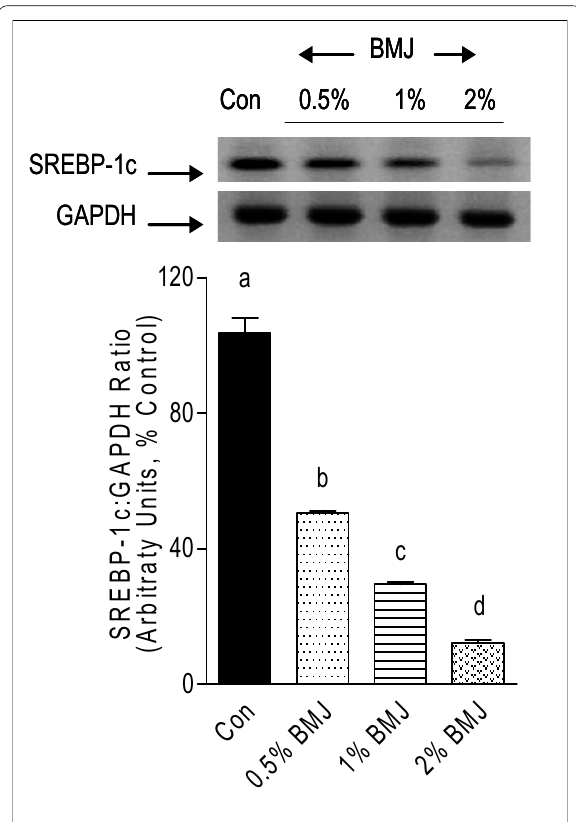
Figure 6 Effect of bitter melon juice on resistin mRNA expression . Differentiating preadipocytes treated with varying concentrations of BMJ (0.5% to 2%, v/v) demonstrate a significant reduction in resistin mRNA gene expression. Bar graphs depict the densitometry scans of resistin gene amplicons (145-bp) and are expressed as a ratio to GAP- DH amplicons (298-bp) intensity. Data are expressed as a percentage of the control (set as 100%) and the values represent the mean ± SE (n = 6) of three independent experiments analyzed in duplicate. a, b, c Mean values with common letters do not differ (p <